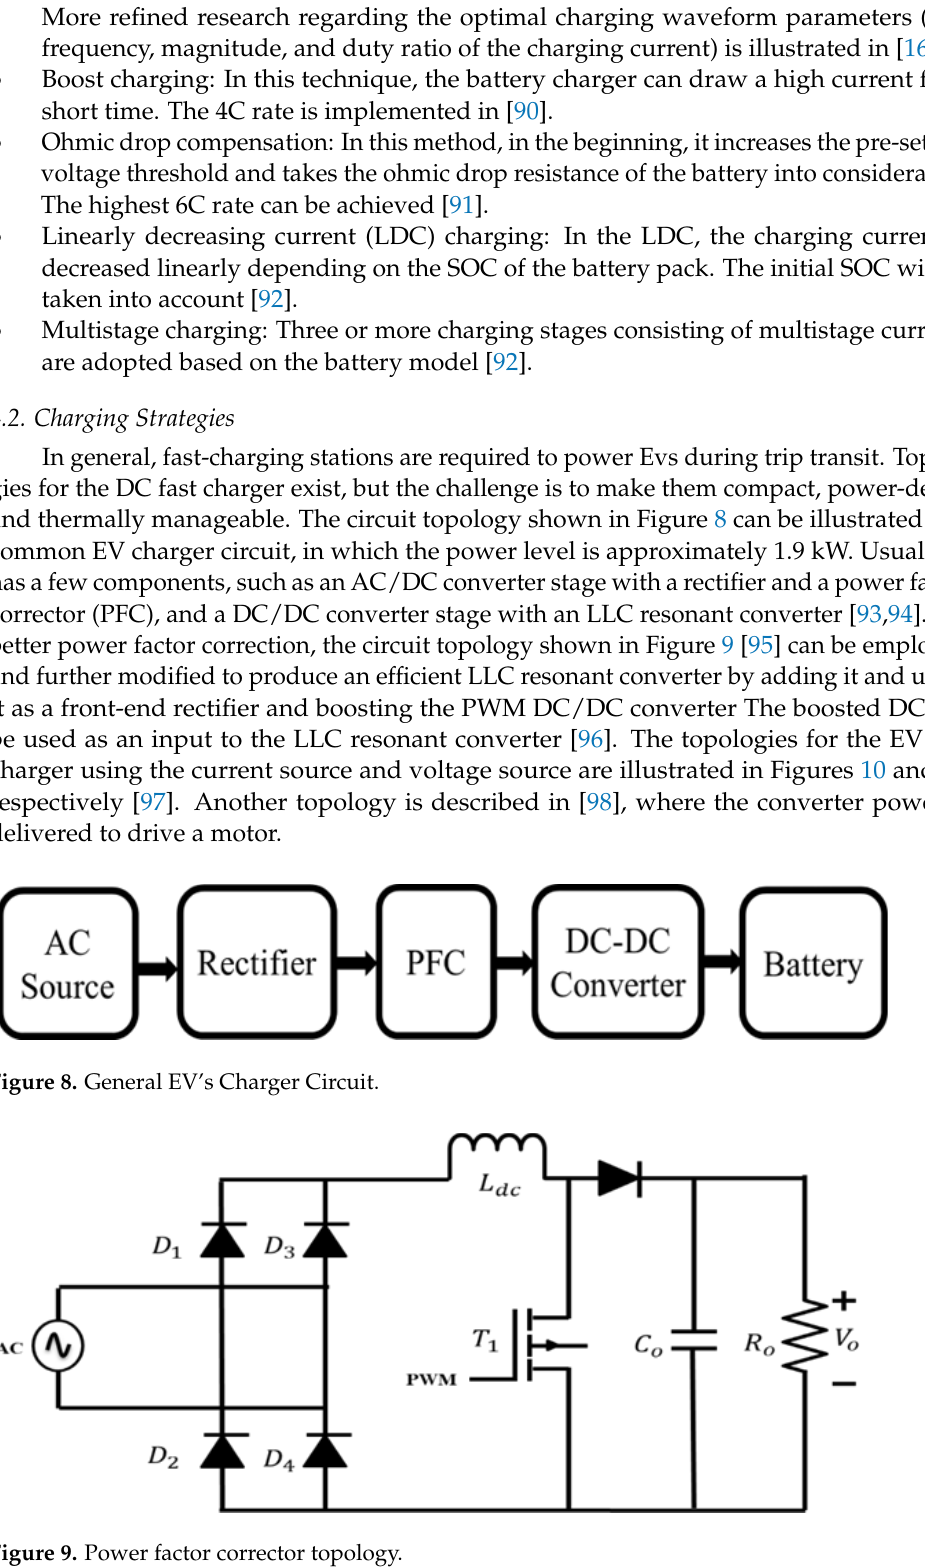
Figure 9. Power factor corrector topology.